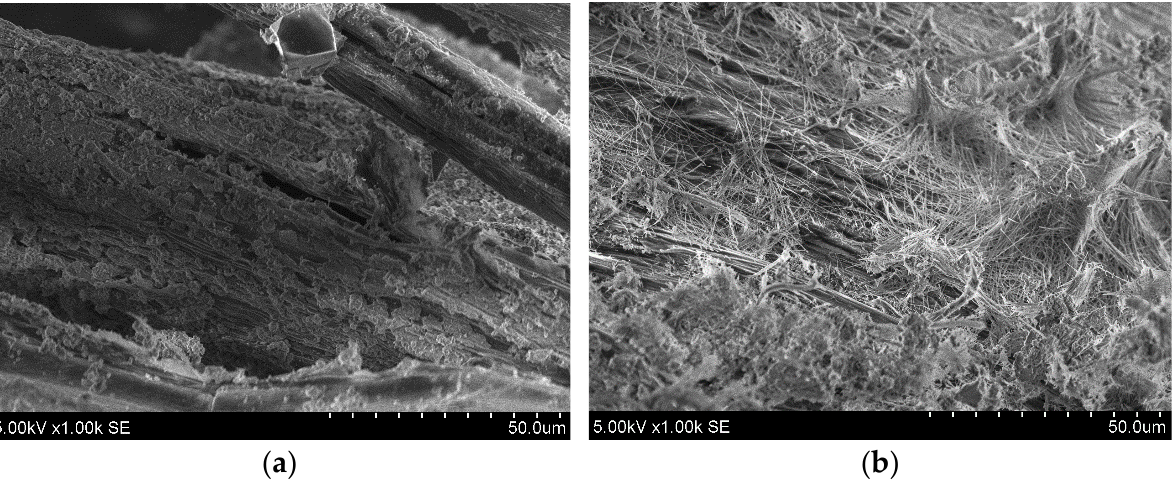
Figure 7. The morphology of polypropylene and hemp fibers; ( a ) surface of polypropylene fiber; ( b ) surface of hemp fiber.